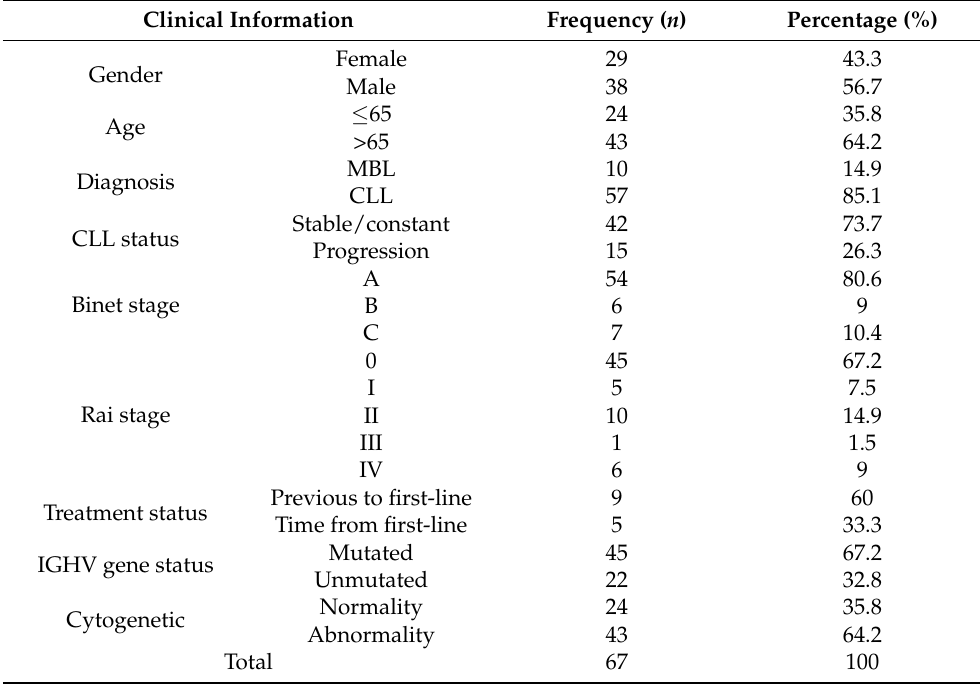
Table 1. Clinical characteristics of patient